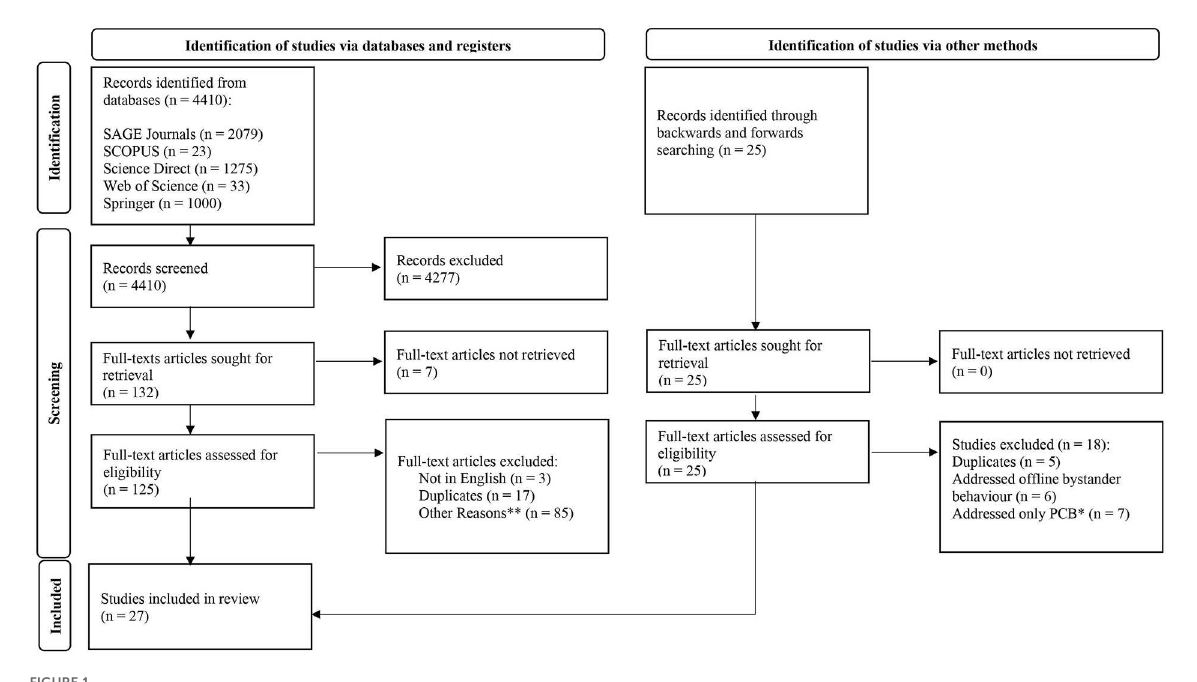
FIGURE1 PRISMA flow-diagram. Source: Page et al.